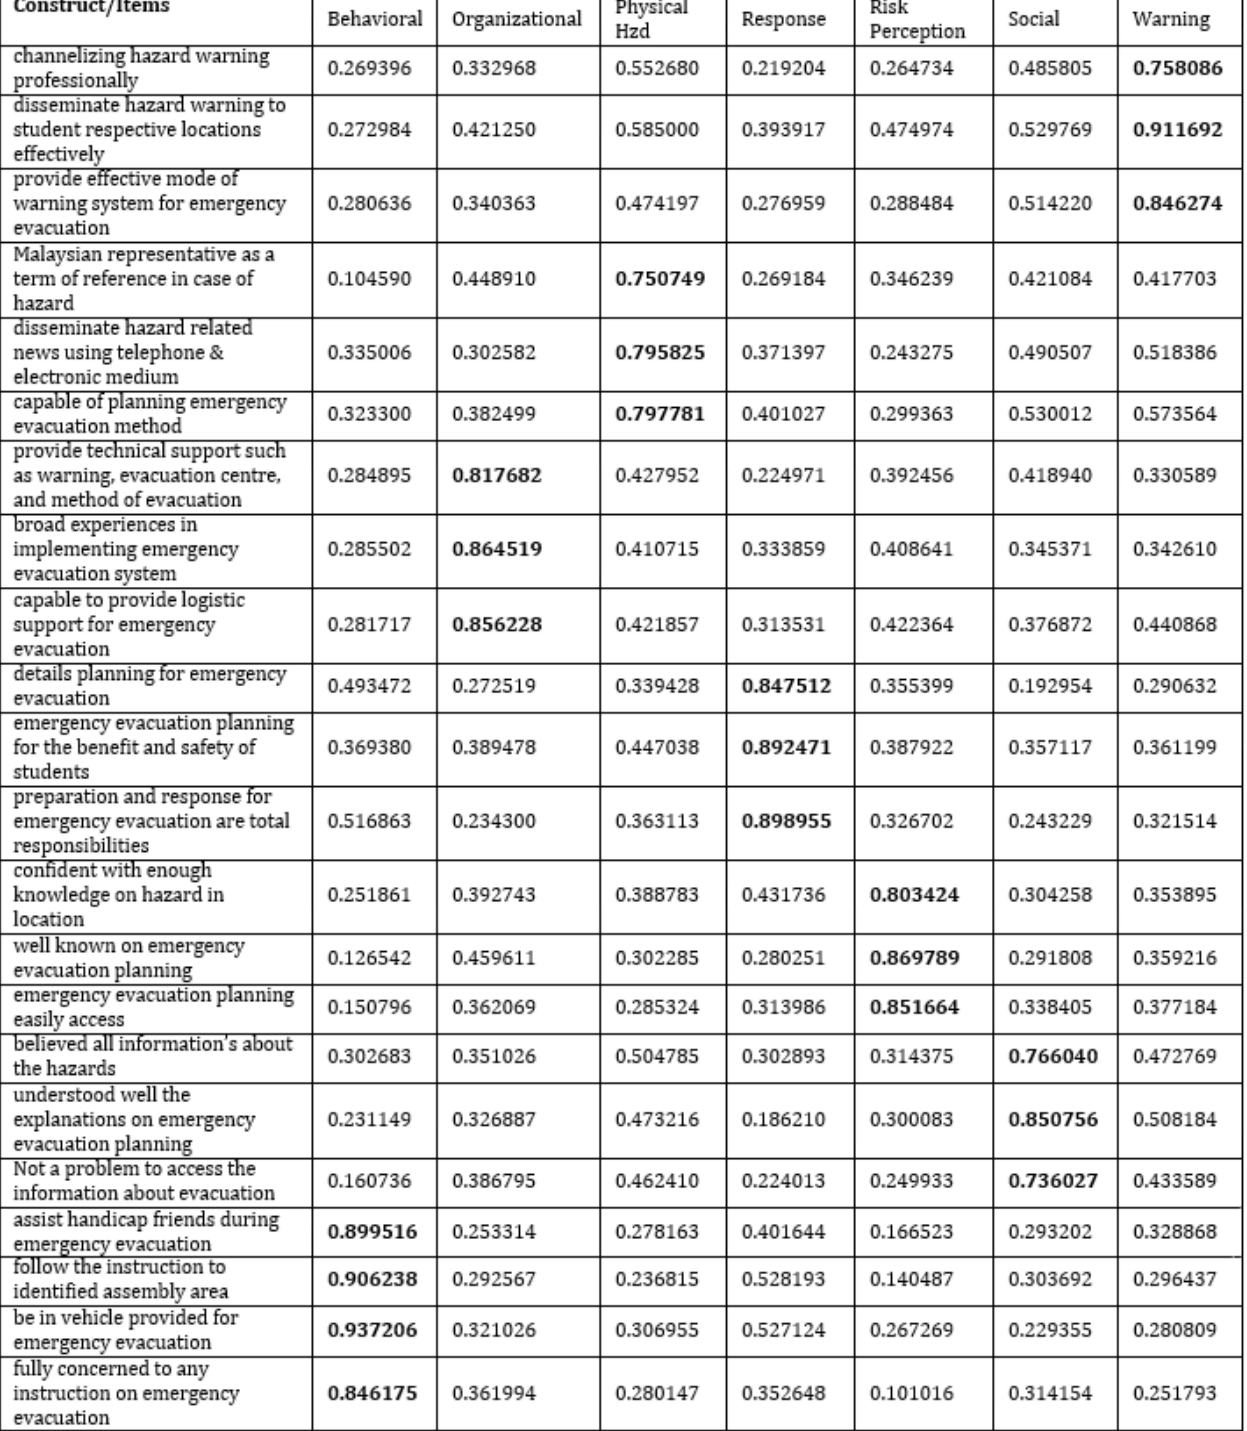
Composite Reliability and Cronbach’s